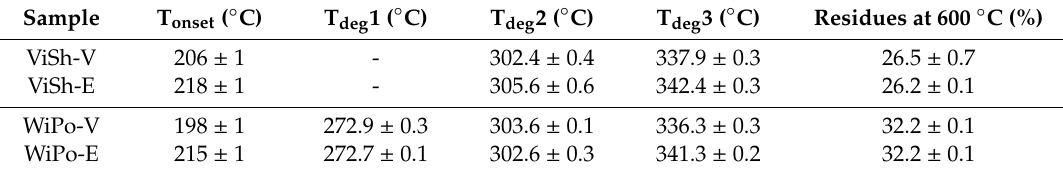
Table 3. Results from the thermogravimetric analysis under N 2 of the ViSh and WiPo fillers. Sample